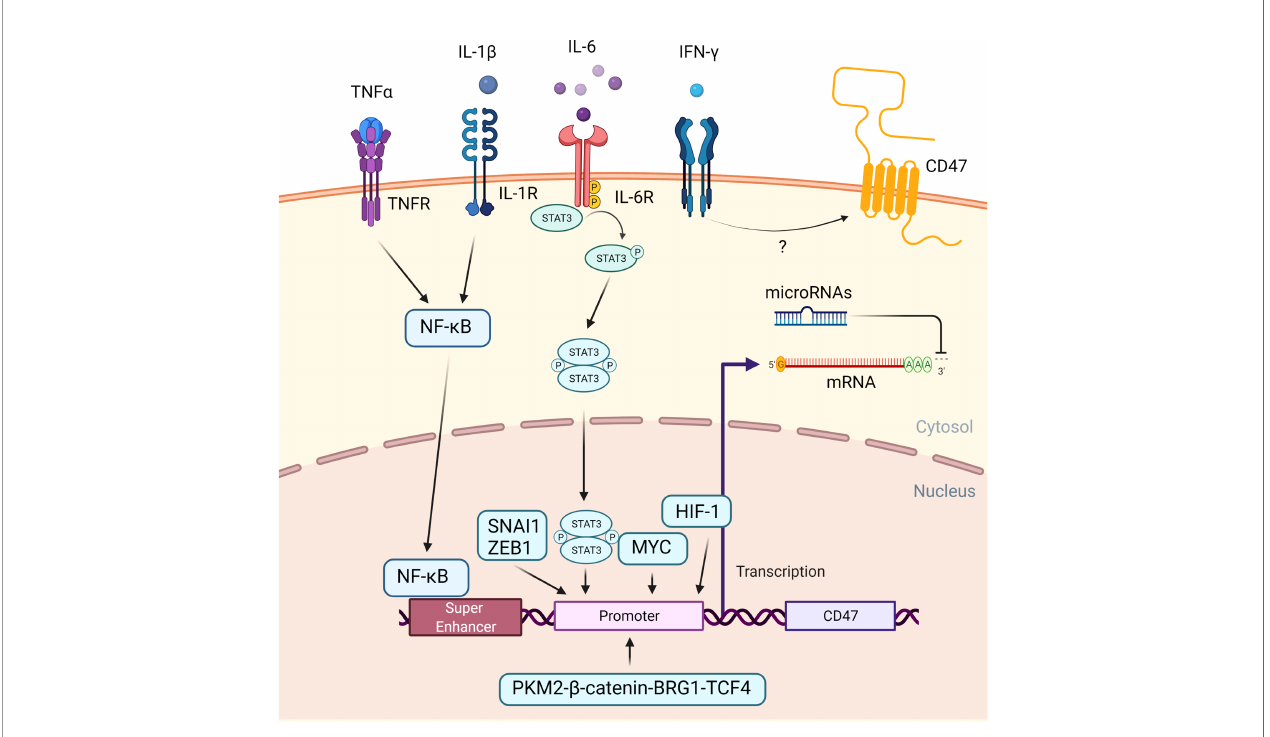
FIGURE 2 | Regulation of CD47 expression in cancer cells. An overview of the mechanisms that cause CD47 overexpression in cancer. When the TNF receptor and the IL-1 receptor are activated by extracellular TNF- a and IL-1, NF k B is recruited and translocated to the nucleus, where it binds to a super-enhancer to promote CD47 expression. Extracellular IL-6 induces STAT3 signaling. Phosphorylated STAT3 complex and other transcription factors, including SNAI1, ZEB1, MYC, HIF-1, PKM2- b -catenin-BRG1-TCF4 complex enhance CD47 expression by directly binding to the CD47 promotor. Extracellular IFN- g increased the CD47 expression, albeit the exact mechanism is unknown. Subsequently, at a post-transcription level, microRNAs could bind to the 3 ’ untranslated region of CD47 mRNA, causing translation to be